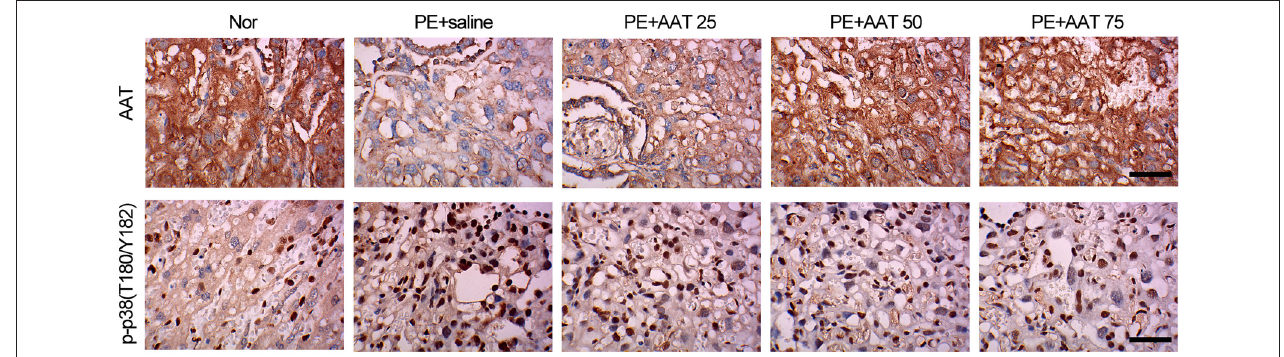
FIGURE 5 | AAT decreases the expression of phosphorylated p38 (T180/Y182) in placenta from PE mice. Representative images of IHC staining for AAT. AAT expression was decreased in placenta from PE mice, and significantly increased after AAT injection (upper); Representative images of IHC staining for phosphorylated p38 (T180/Y182). p-p38 (T180/Y182) expression was enhanced in placenta from PE mice, and significantly decreased after AAT injection (lower). Bar = 50 µ m. N = 8 .